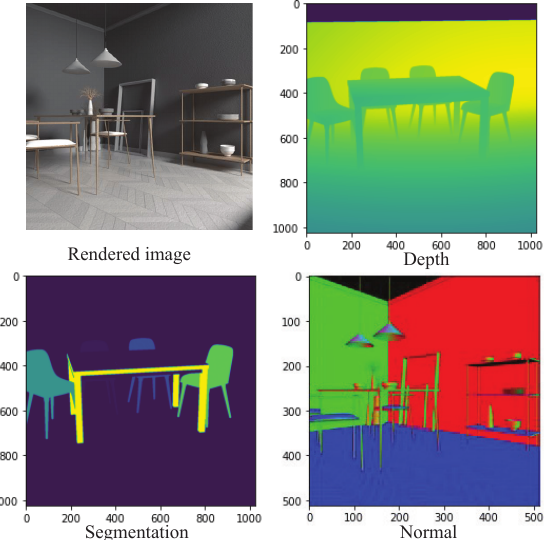
Figure 3. Our rendered light field image depth, segmentation and normal groundtruth maps.